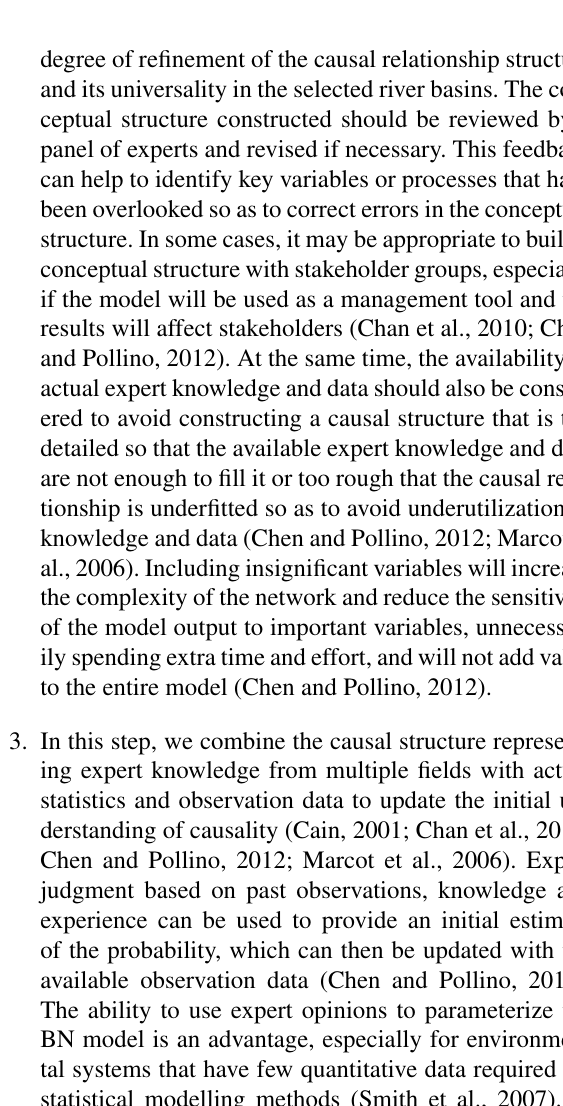
Figure 1. Previous comparative studies focusing on local or individual aspects (a) , and more attention should be directed to the identification and comparison of causality and systemicity between river basins (b)